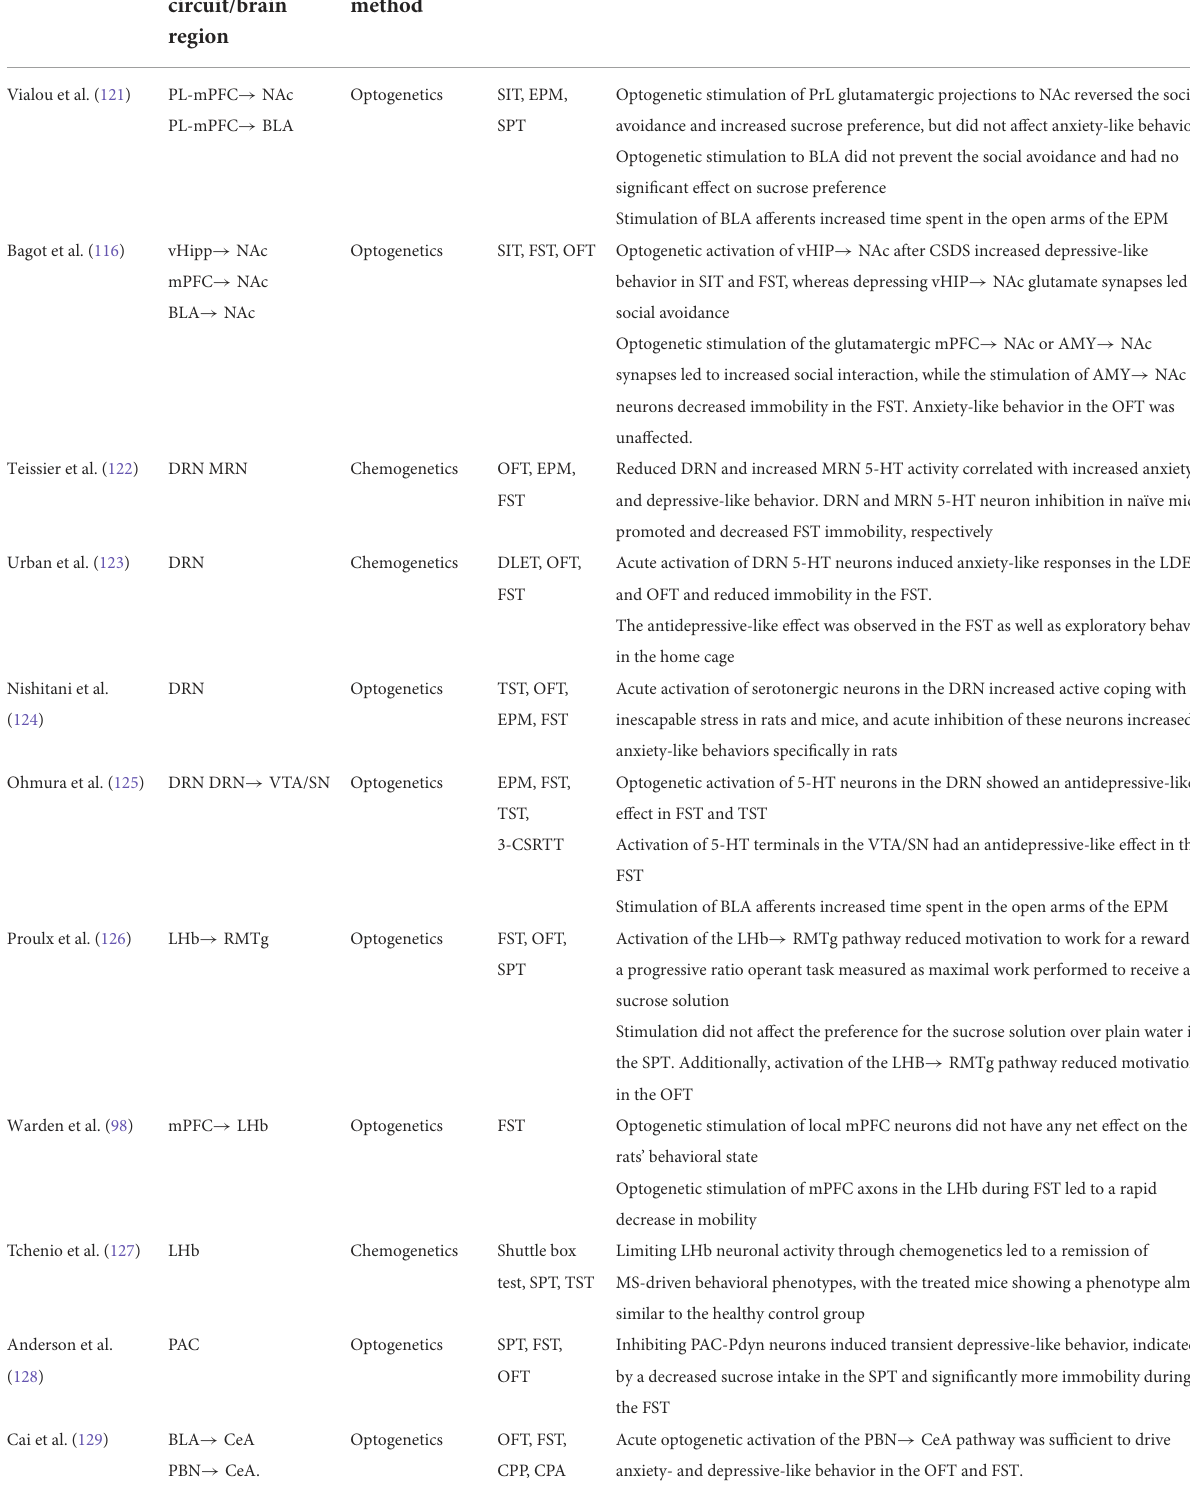
TABLE 1 Other brain regions and neural circuits involved in